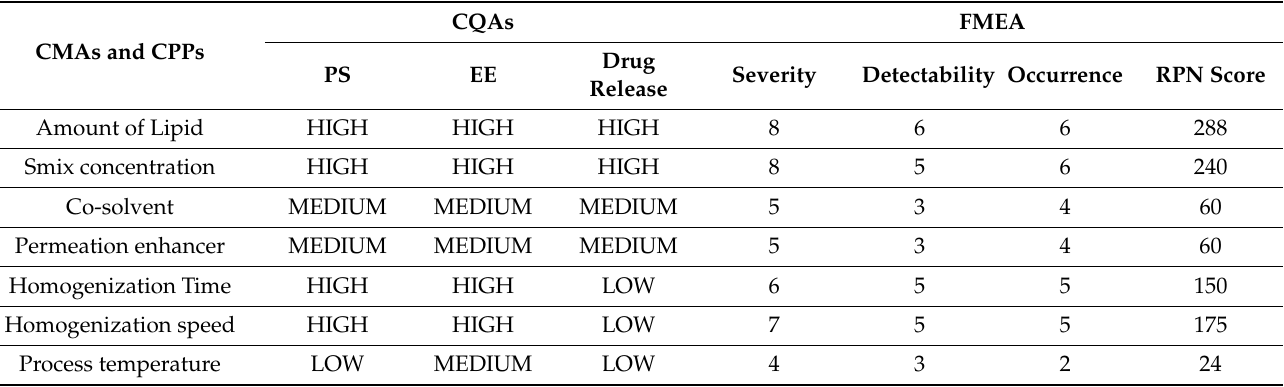
Table 1. REM for initial risk assessment and FMEA score based on qualitative analysis of different material attributes and process parameters.